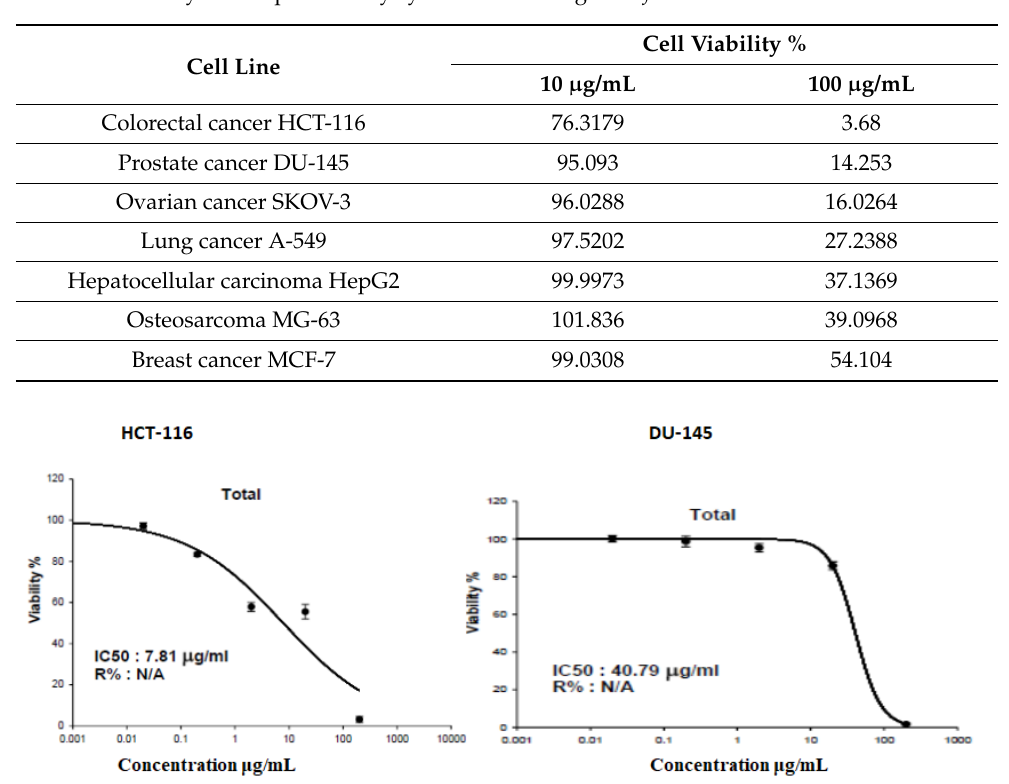
Table 3. Summary for the preliminary cytotoxic screening of A. fruticosus leaf methanolic extract.